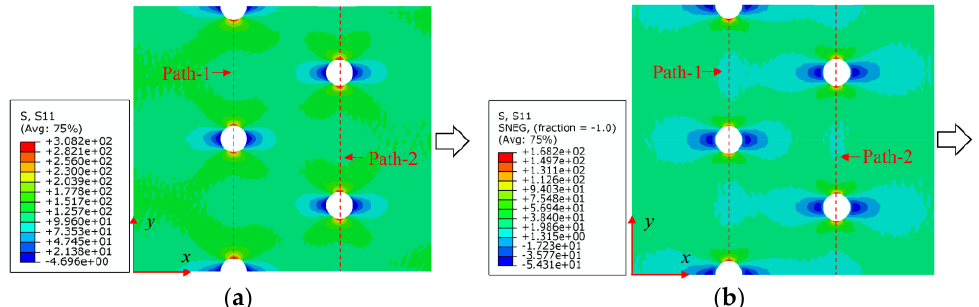
Figure 8. Axial stress distribution in constituents of on-axis H5R2S specimen: ( a ) aluminum; ( b ) 0° GFRP. ( b ) 0 ◦